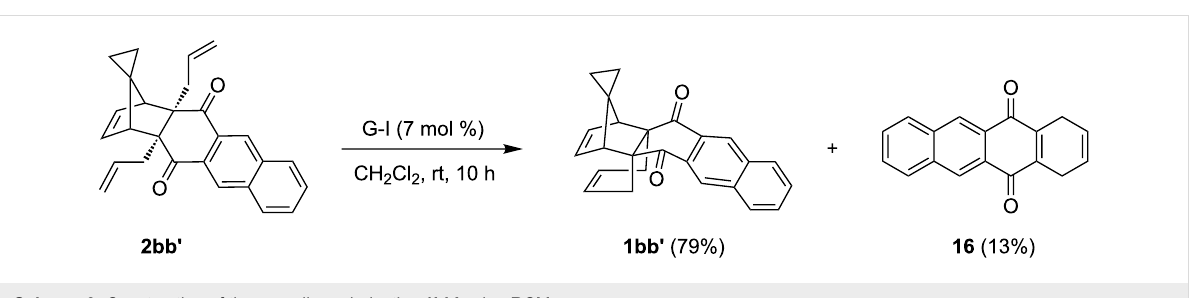
Scheme 6: Construction of the propellane derivative 1bb' using RCM.